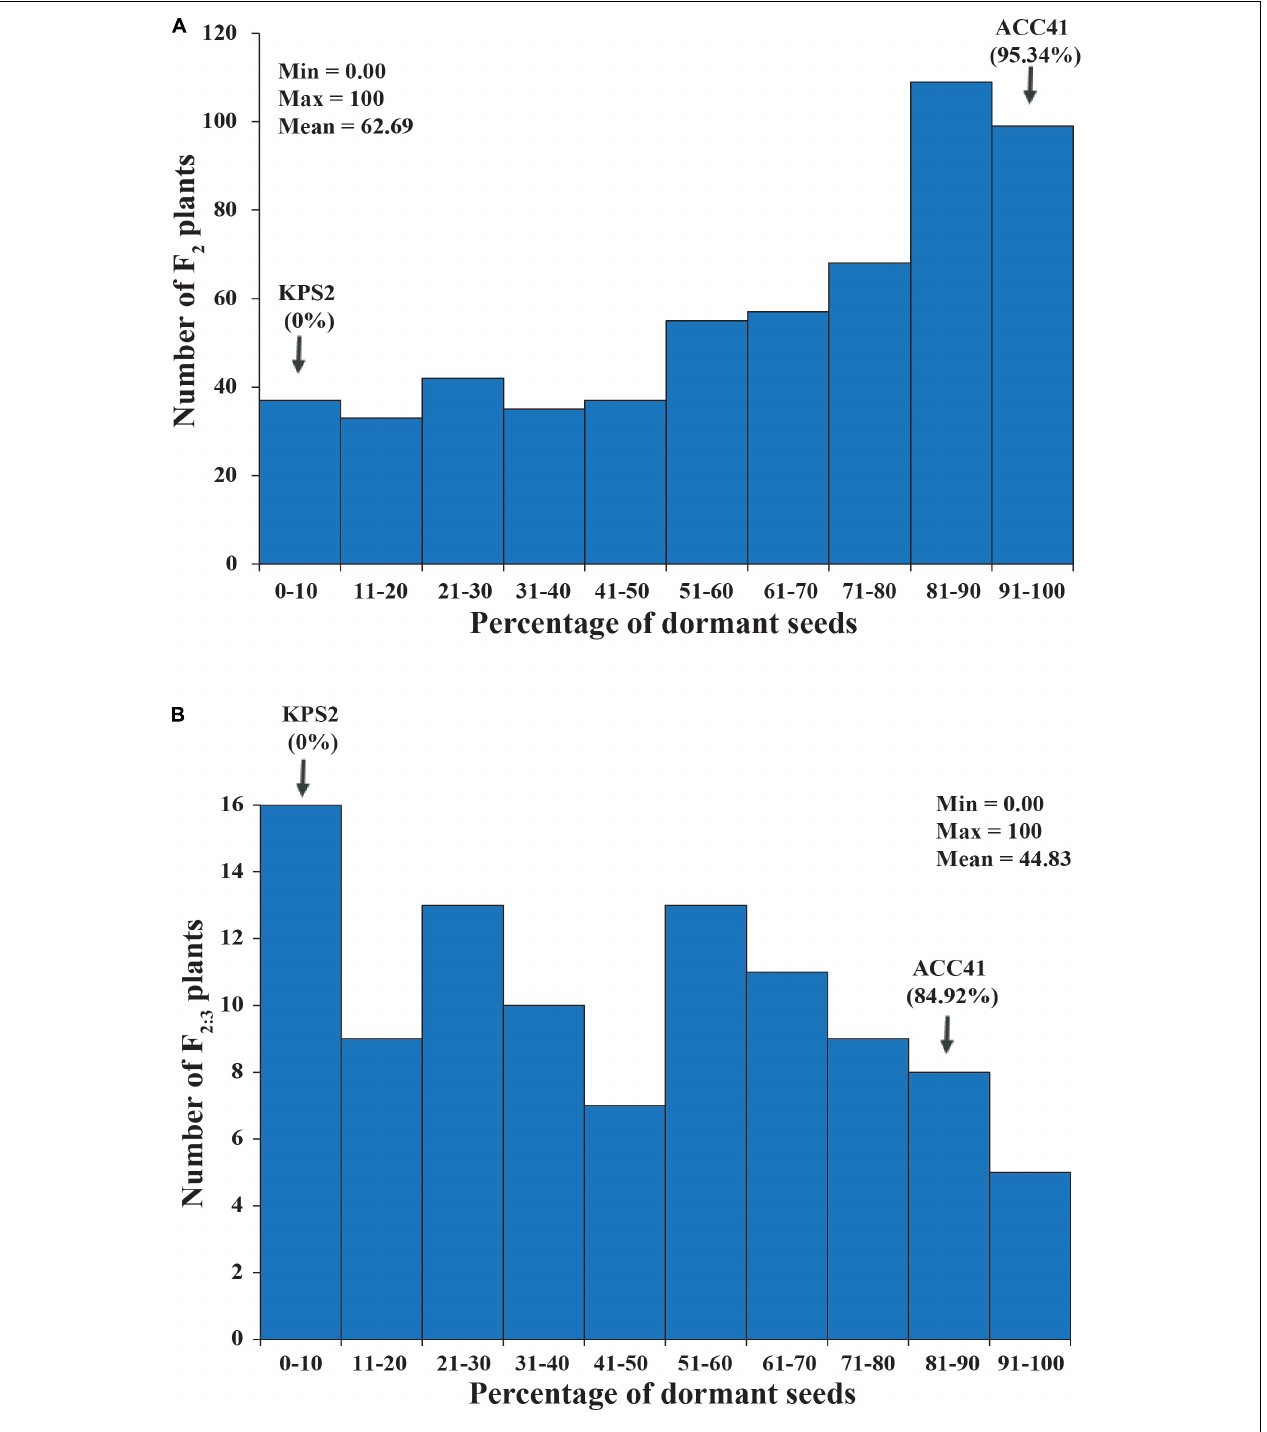
FIGURE 3 | Frequency distribution of the percentage of dormant seeds (PDSs) in F 2 population of 573 individuals (A) and F 2 : 3 population of 100 individuals (B) derived from the cross between KPS2 and ACC41.